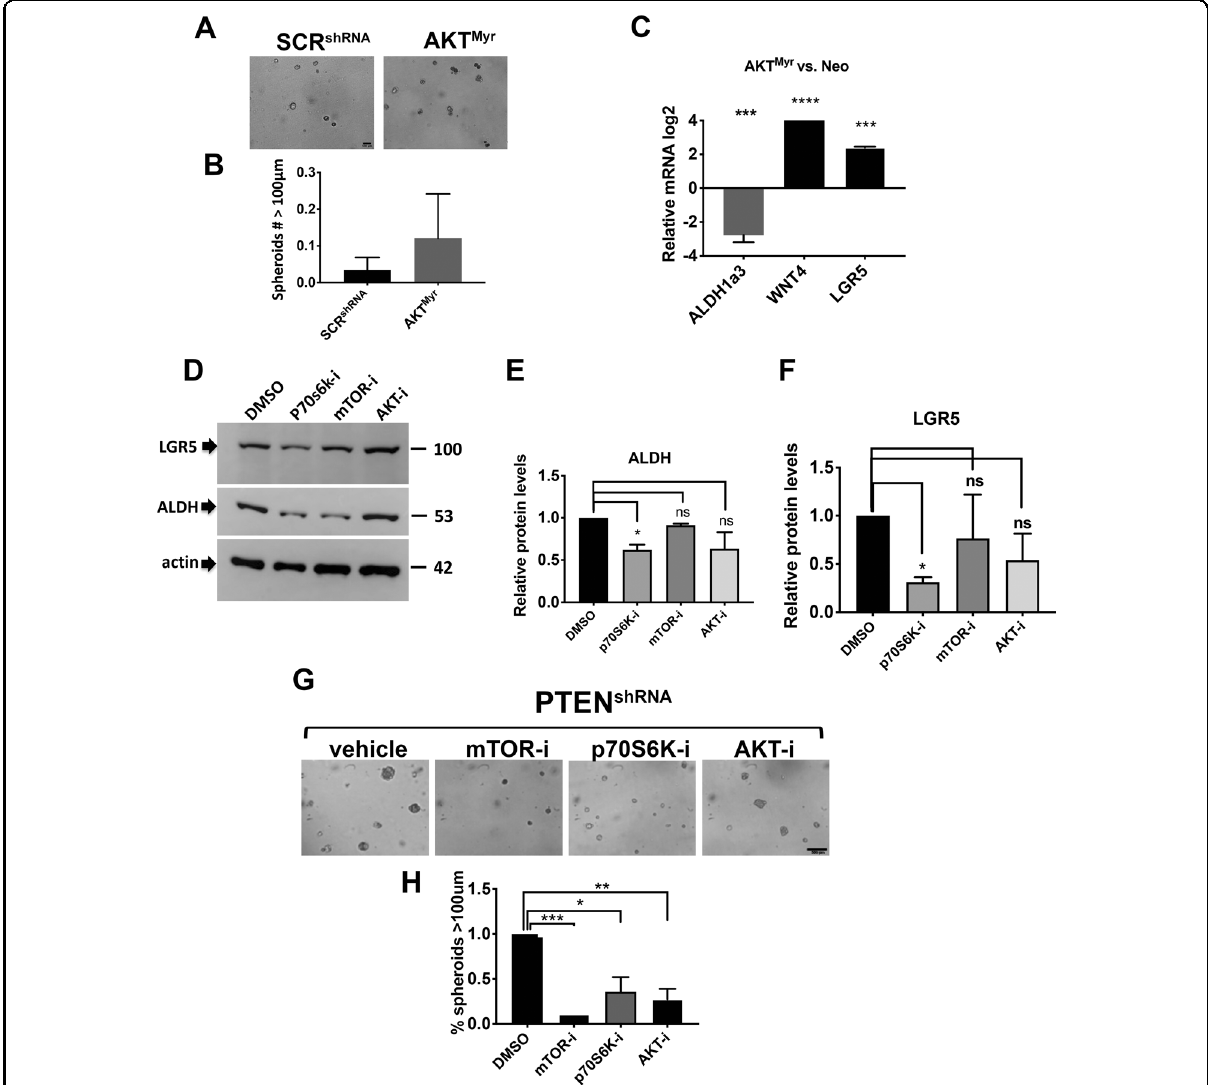
Fig. 5 mTOR activation is critical for CSC function. A , B Spheroid formation in matrigel of control cells and constitutively active AKT Myr were imaged. Scale bar represents 500 μ m. Number of spheroids with diameter higher than 100 μ m were counted using Celigo (Nexcelom). Statistical analysis was performed using one-way ANOVA. C Control cells and constitutively active AKT Myr were seeded, RNA was extracted, and qPCR performed in three independent experiments *** p < 0.001; **** p < 0.0001. D – F PTEN shRNA cells were treated with DMSO as a vehicle or pAKT inhibitor, MK2206 (10 μ M), pmTOR inhibitor, Rapamycin (20 nM), or pP70S6k inhibitor, PF-04708671 (25 μ M) and processed for Western blots to detect ALDH and LGR5. Quanti fi cation of western blots from three independent experiments was performed using ImageJ and normalized by actin. * p < 0.05. G , H Spheroid formation in matrigel of PTEN shRNA cells treated with DMSO vehicle or pAKT inhibitor, MK2206 (10 μ M), pmTOR inhibitor, Rapamycin (20 nM), or pP70S6K inhibitor, PF-04708671 (25 μ M). Scale bar represents 500 μ m. Spheroids were imaged and the number with